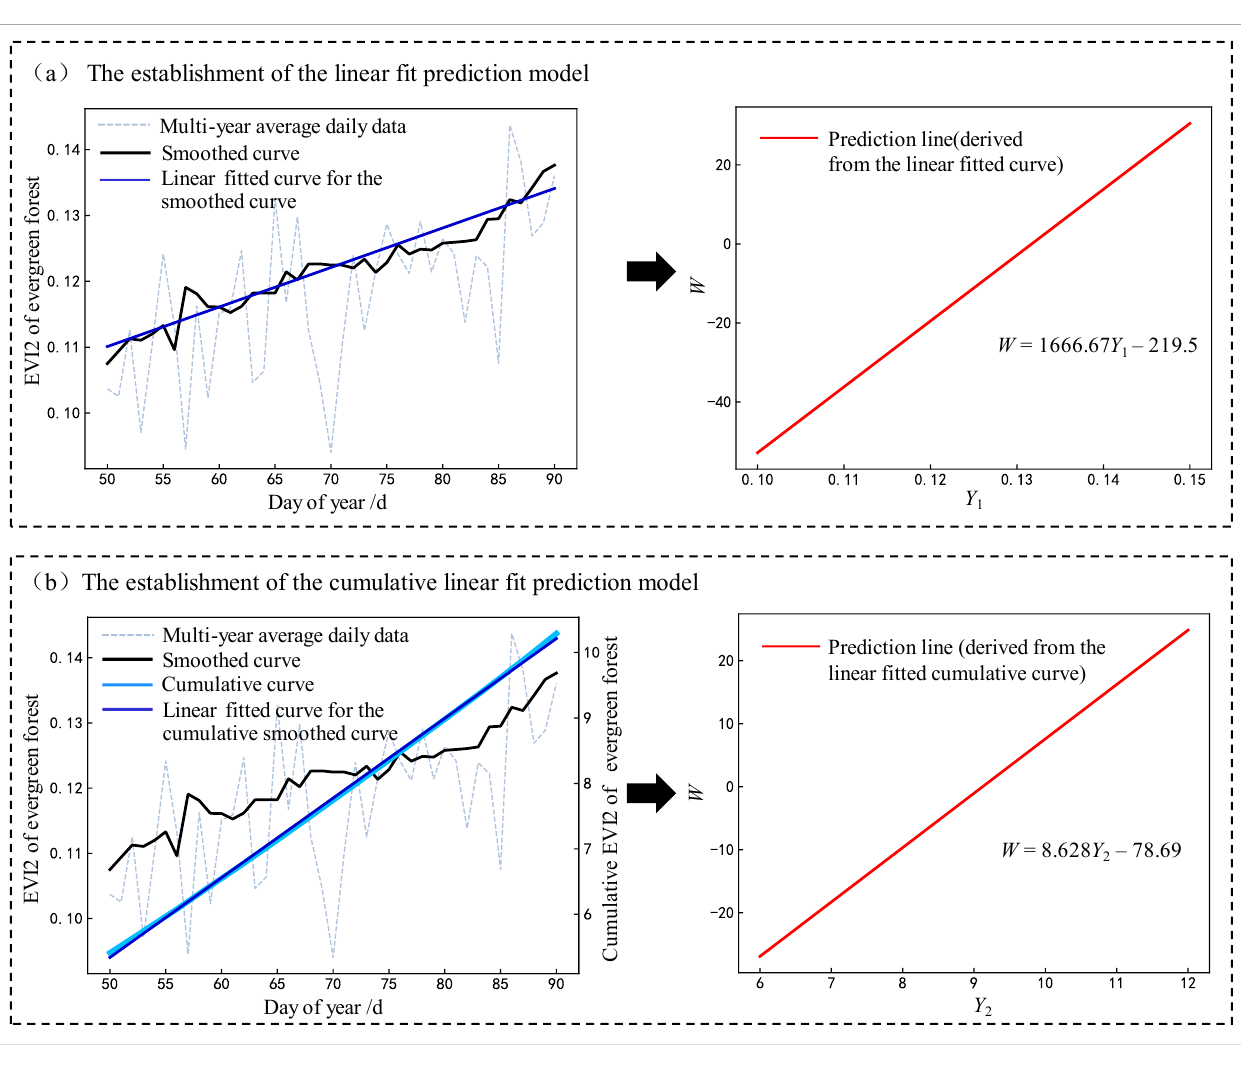
Figure 4. The establishment of two prediction models based on EVI2 of evergreen forest during 2011–2021. W is the number of days to the outbreak date of spring pollen allergy in Beijing, Y 1 is the smoothed daily EVI2 value of evergreen forest for a given forecast year, and Y 2 is the cumulative smoothed daily EVI2 value of evergreen forest for a given forecast